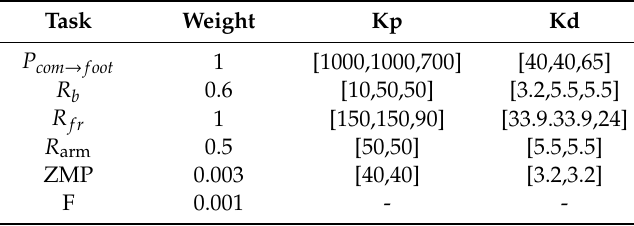
Table 2. Weights and gains in